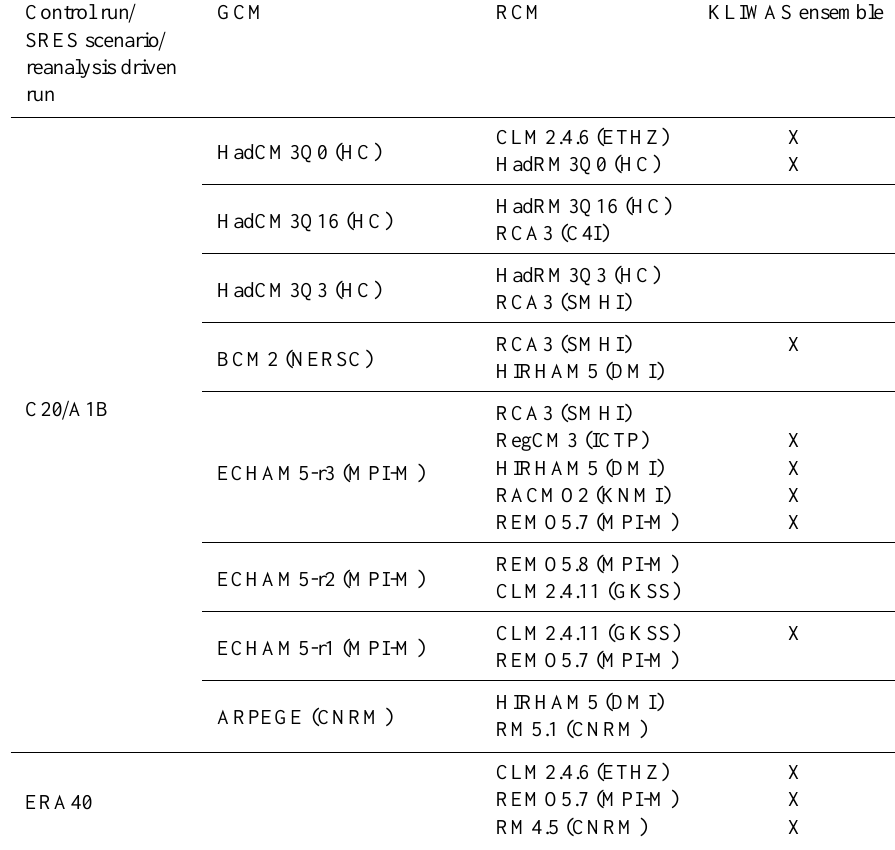
Table 1. Overview of climate simulations of the years 1961–2000 for the control run (C20), projection runs for the years 2001–2100 based on the scenario A1B and Re-Analysis driven runs (ERA40) used in this study. The symbol X in the last column indicates the projections that are regionalised and